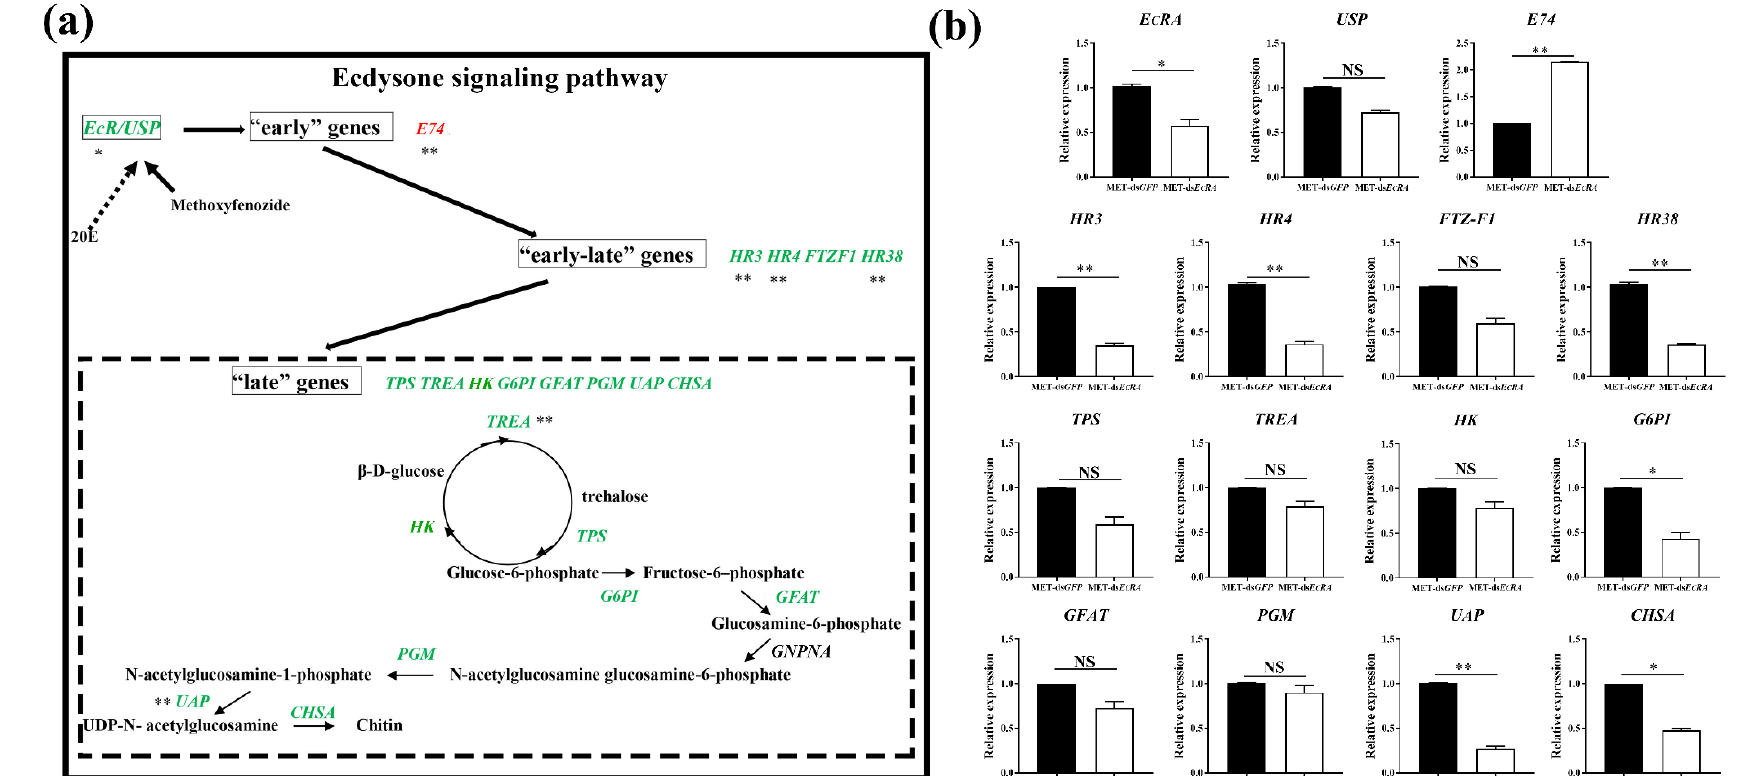
Figure 5. Ecdysone signaling pathway in insects. ( a ) 20E can bind to combine EcRA and USP, but MET can advance combination with EcRA and result in lethal molting. The compound could activate downstream genes. Downstream genes contain three category genes. The early genes contain E74 , while early–late genes contain HR3 , HR4 , FTZ-F1 , and HR38 . Late genes contain chitin synthesis genes. Β - D -glucose is converted to Glucose-6-phosphate, Fructose-6-phosphate, Glucosamine-6-phosphate, N-acetylglucosamine glucosamine-6-phosphate, N-acetylglucosamine-1-phosphate, UDP-N- acetylglucosamine, and then to chitin. The activity of the enzymes encoded by TPS , TRE , HK , G6PI , GFAT , GNPNA , PGM , UAP , and CHSA . Significant differences were calculated by Student’s t -test (* p < 0.05; ** p < 0.01). ( b ) Relative expression of ecdysone signaling pathway genes after they were injected with ds EcRA in S. exigua under MET treatment. Columns represent averages, with vertical lines indicating SE. Significant differences were calculated by Stud ent’s t -test (NS, p > 0.05; * p < 0.05; ** p < 0.01).